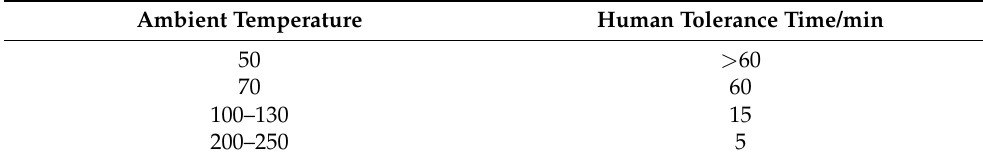
Table 5. The effect of temperature on the human body.